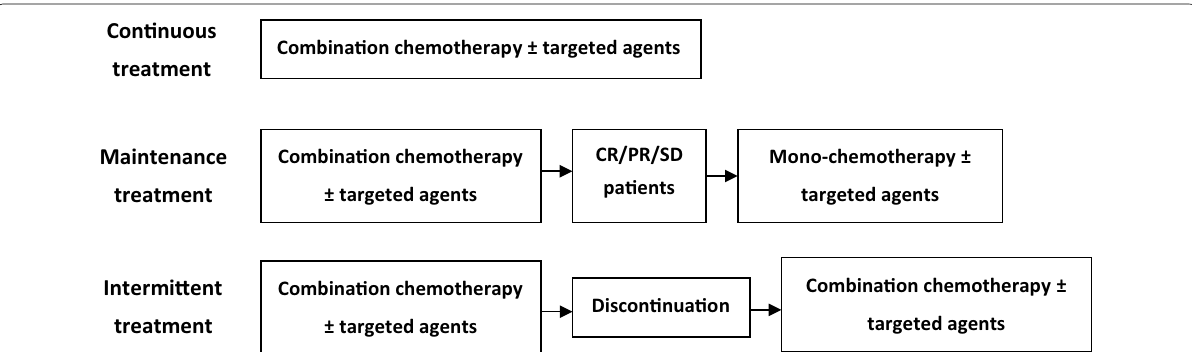
Fig. 1 Schematic diagram of continuous, maintenance, and intermittent treatment patterns. FOLFOX [oxaliplatin, 5‑fluorouracil (5‑FU) plus folinic acid], FOLFIRI (irinotecan, 5‑FU plus folinic acid), CapeOx (capecitabine plus oxaliplatin), and FOLFOXIRI (oxaliplatin, irinotecan, 5‑FU plus folinic acid) regimens were used for combination chemotherapy. Bevacizumab or cetuximab was used as targeted agents. CR complete remission, PR partial remission, SD stable disease